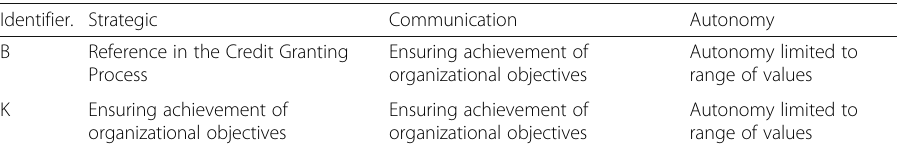
Table 8 Final alternatives Identifier.